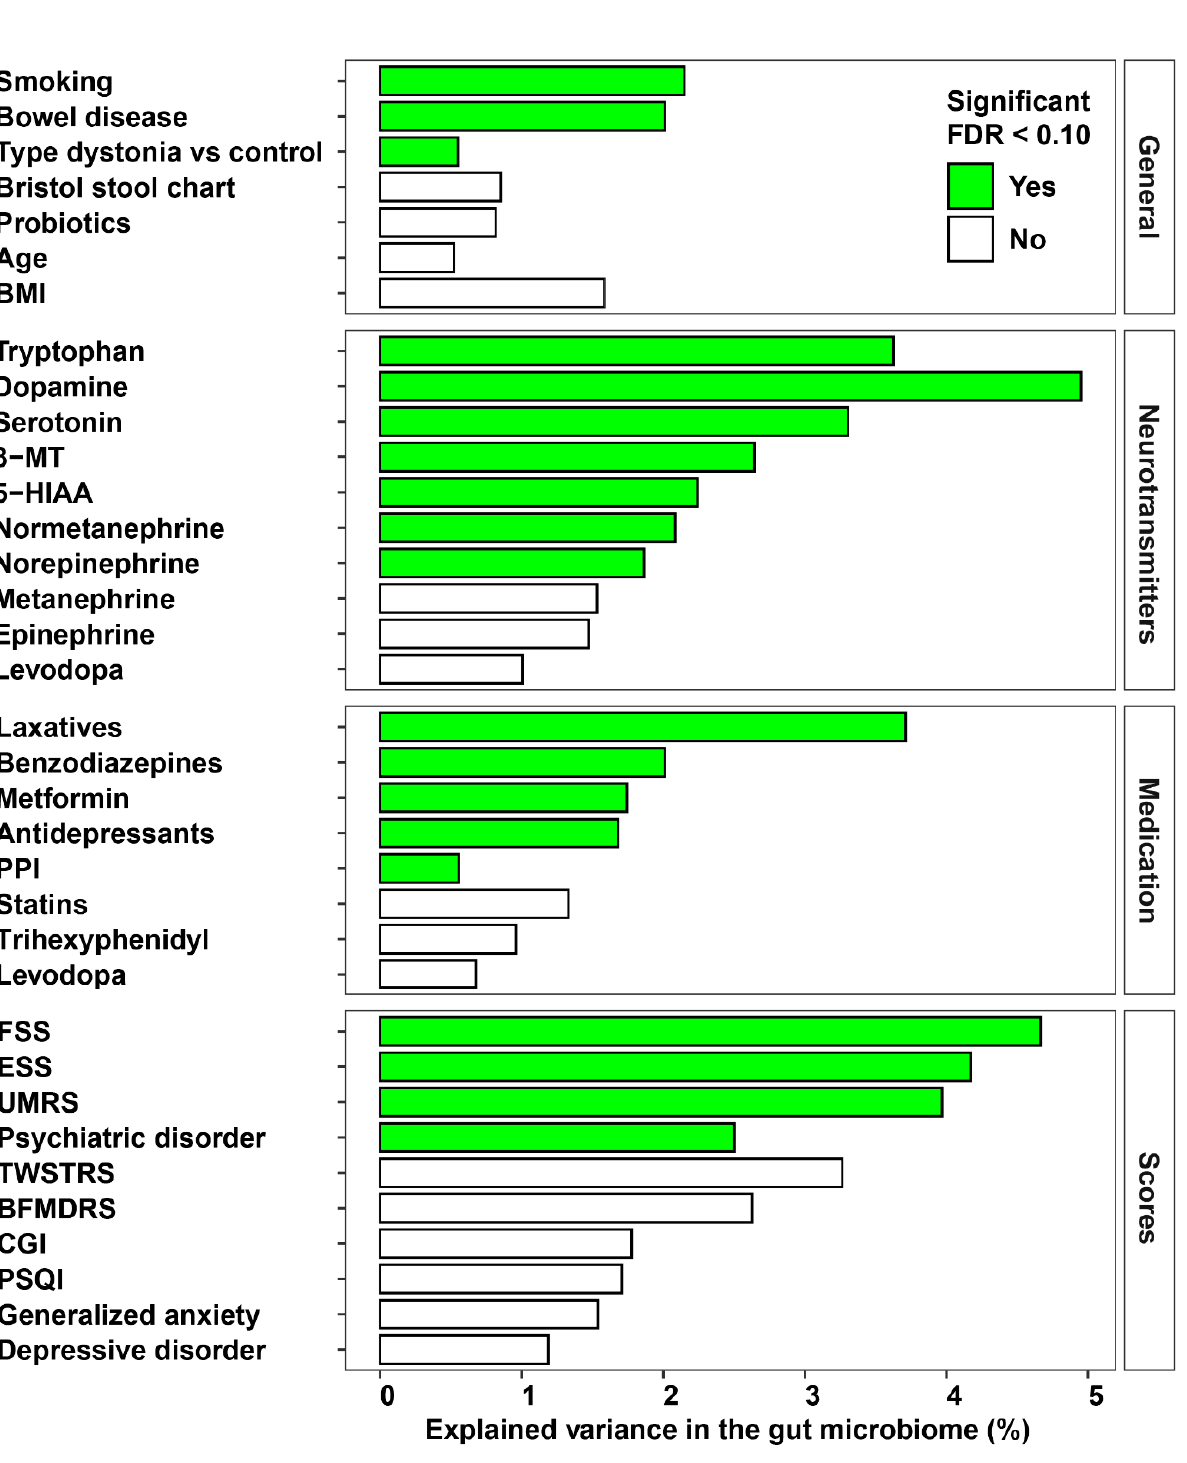
Figure 3. Results of the permutational multivariate analysis of variance using distance matrices (PERMANOVA) to assess the explained variance in the Aitchison distance matrix.